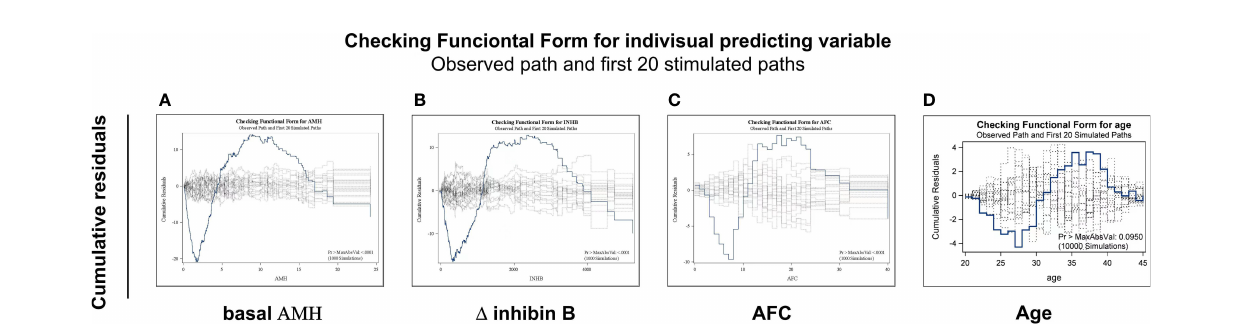
FIGURE 2 | Exploring the functional forms of each predictive variable based on the cumulative sums of residuals. Functional forms of AMH (A) , D inhibin B (B) , AFC (C) and age (D) based on the cumulative sums of residuals. The heavy line represents the observed cumulative residuals and the light line represents the stimulated theoretical cumulative residuals. If the heavy line deviated from the 10,000 light curves, a more complicated form instead of a linear one is needed for the predictive variables. Only fi rst 20 simulated paths are shown in each